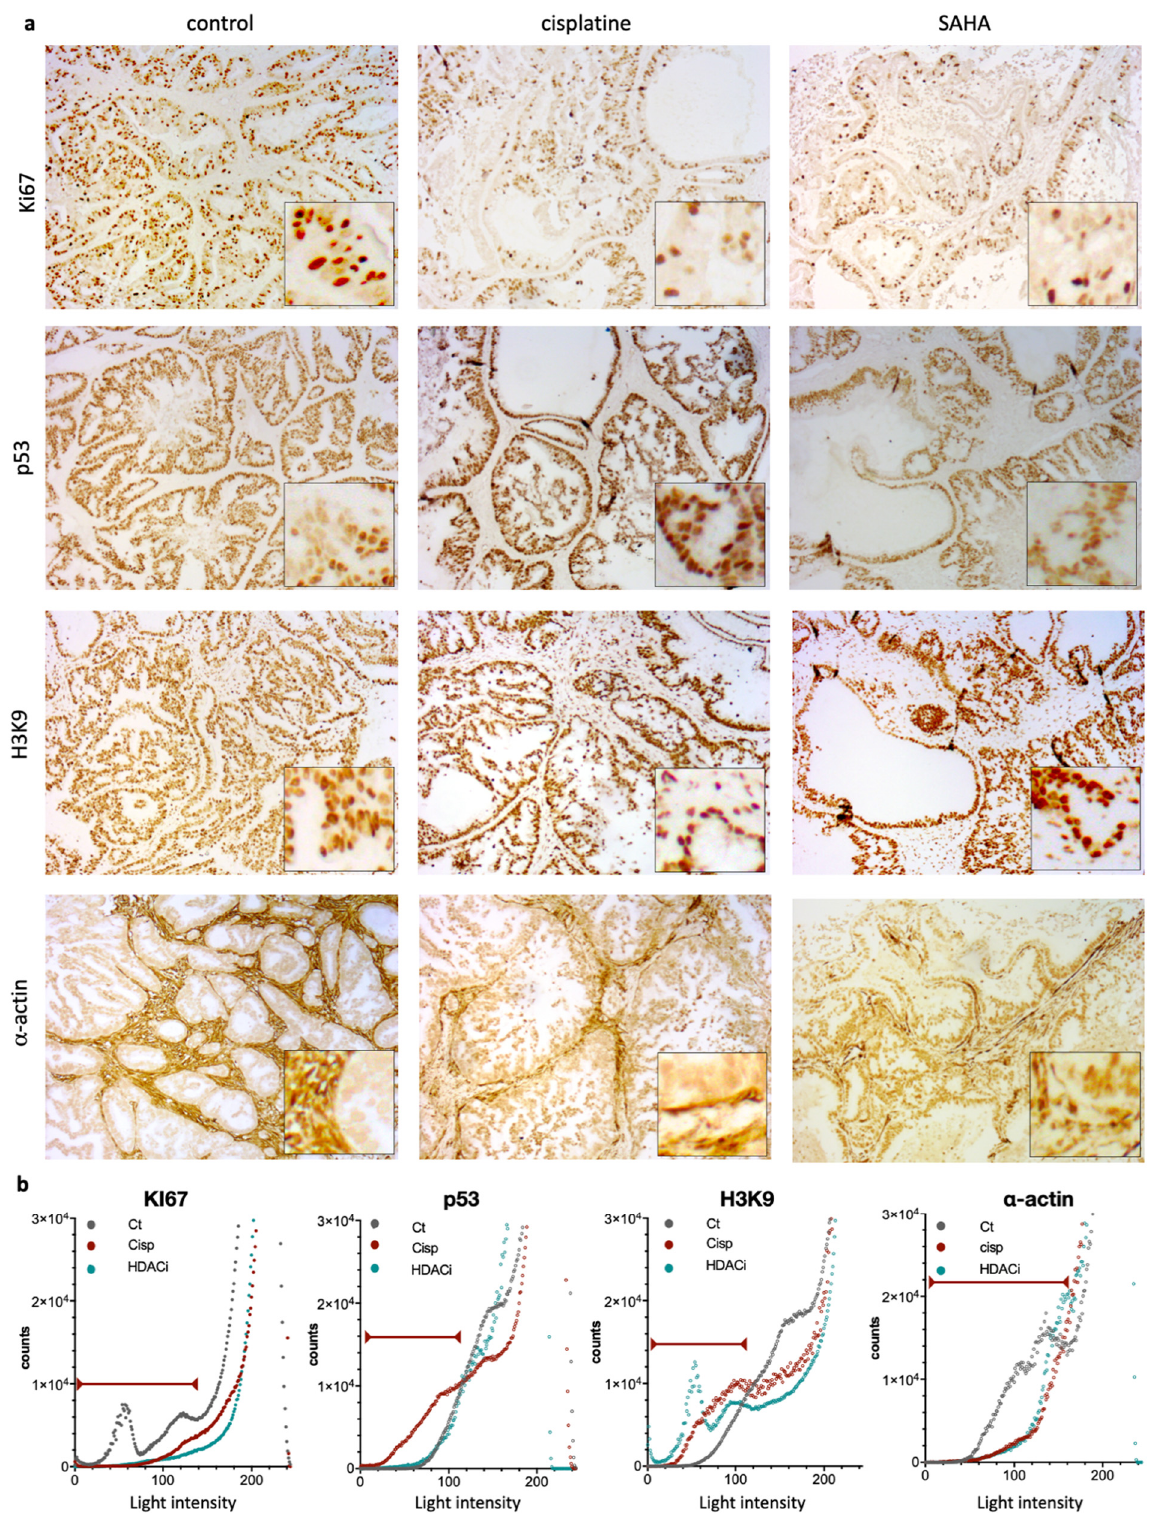
Figure 5. Immunohistochemical (IHC) staining and intensity measures for Ki67, p53, H3K9, and α -actin. ( a ) Representative photomicrographs of the expression of Ki67, p53, H3K9, and α -actin for treatment group (control, cisplatin, and SAHA (magnification × 20 with close up × 40). ( b ) Quantifications by Fiji software of each condition. Graphs represent number of pixels for each light intensity from 0 to 255. Red lines indicate the relevant values as considered, based on negative control (e.g., no primary